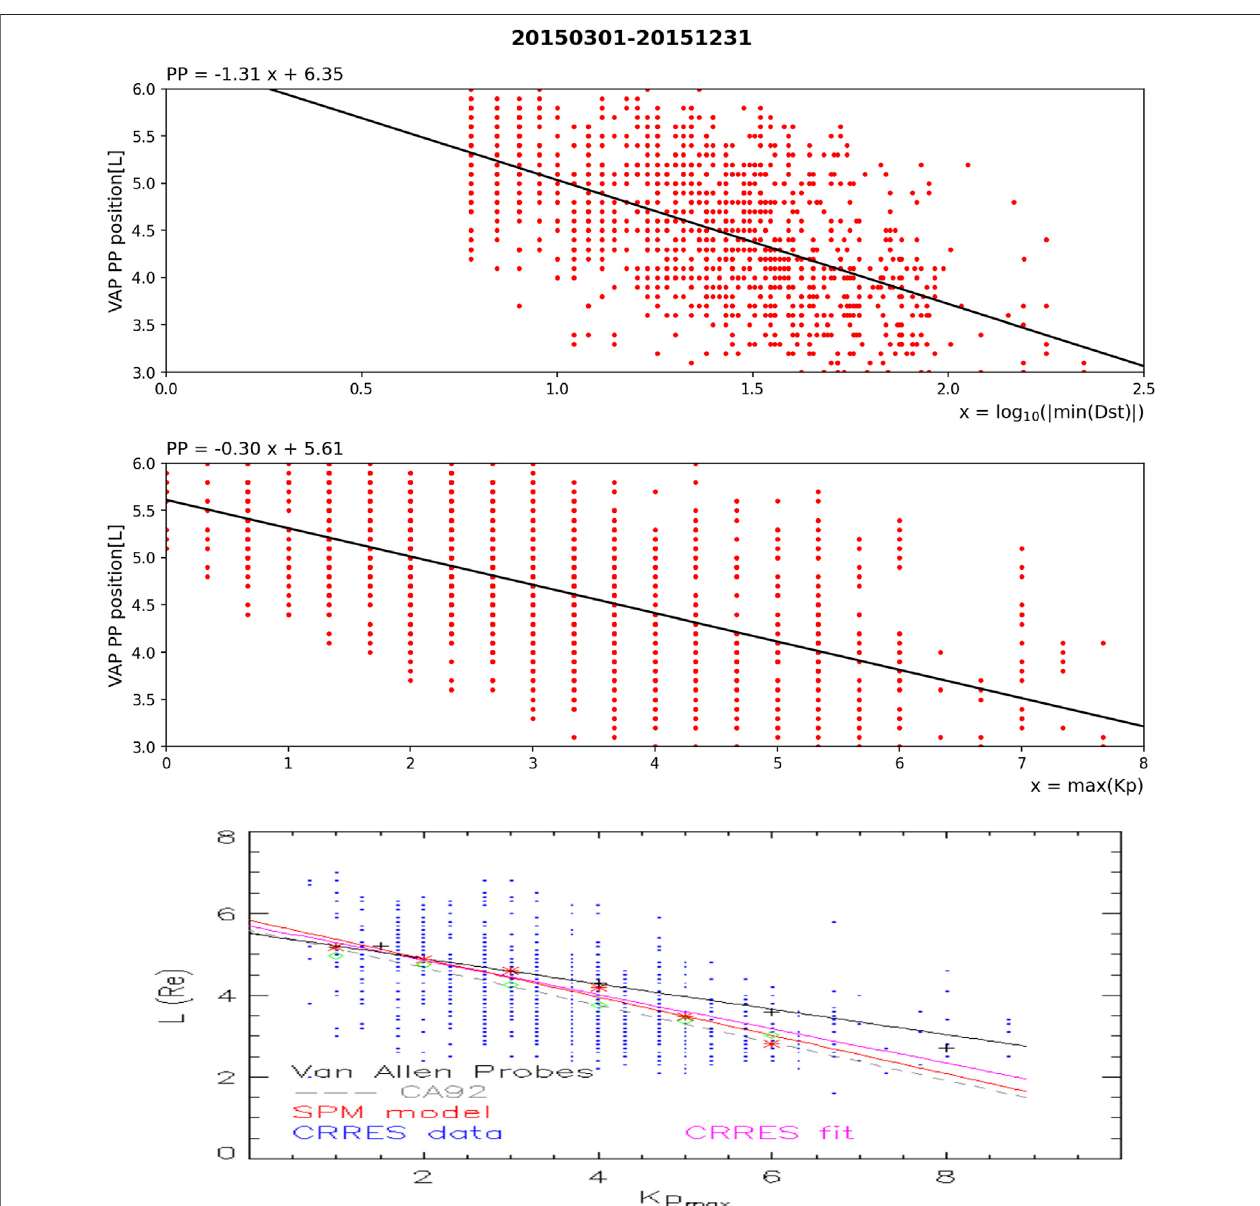
FIGURE1|Upperpanel: PlasmapauseobservedbyProbeBoftheVanAllenProbesfrom1-3-2015to31-12-2015asafunctionofthelogarithmoftheminimumvalueof Dstobservedduringtheprevious24 h.Thebestlinearrelationisprovidedbytheblacklineforwhichtheexpressionisshownabovethepanel. Middlepanel: Sameplasmapause observedbyProbeBoftheVanAllenProbesfrom1-3-2015to31-12-2015asafunctionofmax(Kp)duringtheprevious24 h.Thebestlinearrelationisprovidedbytheblackline for which the expression is shown above the panel. Bottom panel: (Blue dots) Plasmapause Lpp observed by CRRES as a function of Kp maximum during the previous 12 h(Greendiamonds)AveragedvaluesofCRRESLppasafunctionofKp.(Pinkline)PlasmapauselinearrelationfoundbyMoldwinetal.(2002)inthe21-03 hMLTsector.(Gray dashedline)PlasmapauselinearrelationfoundbyCarpenterandAnderson(1992)fromISEEdata.(Blackcrosses)MeanplasmapausemeasuredbyVanAllenProbesfrom2012 to2019forfourKprangesinthenightside.(Blackline)PlasmapauselinearrelationfoundintoppanelwithVanAllenProbesdatafromMarchtoendDecember2015.(Redstars) Plasmapause positions found with the SPM model as a function of Kp. (Red line) Plasmapause linear relation found with the SPM